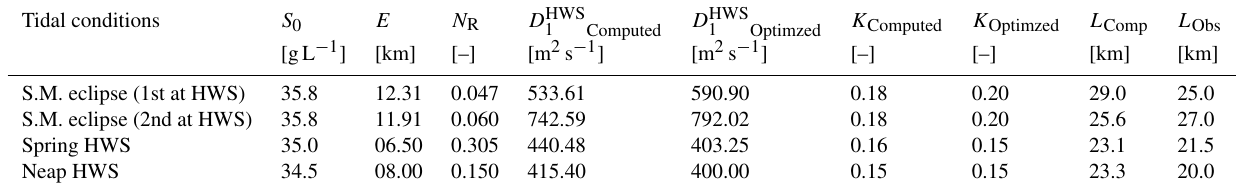
Table 5. Salinity distribution data showing the salinity at the mouth ( S 0 ), tidal excursion ( E ), Richardson number ( N R ), dispersion coefficient at high water slack, Van Der Burgh’s coefficient ( K ) and salt intrusion length at high water slack ( L ). S.M. stands for supermoon. Tidal